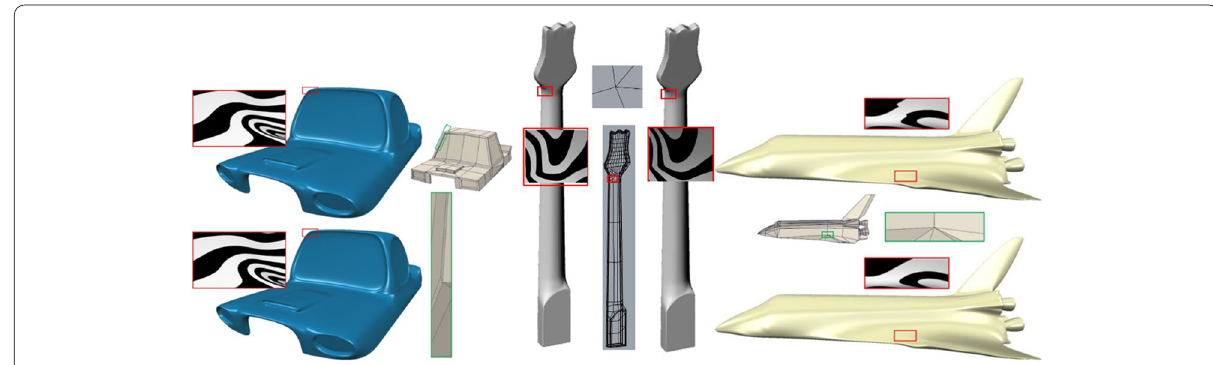
Fig. 12 Three real